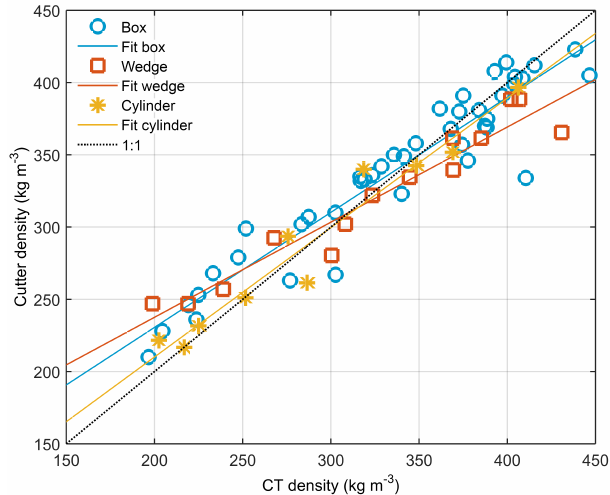
Figure 5. Different measurement methods averaged to match the traditional layers vs. the mean layer density. Mean layer densities are the average of all layer densities of the different methods. Statis- tics are given in Table